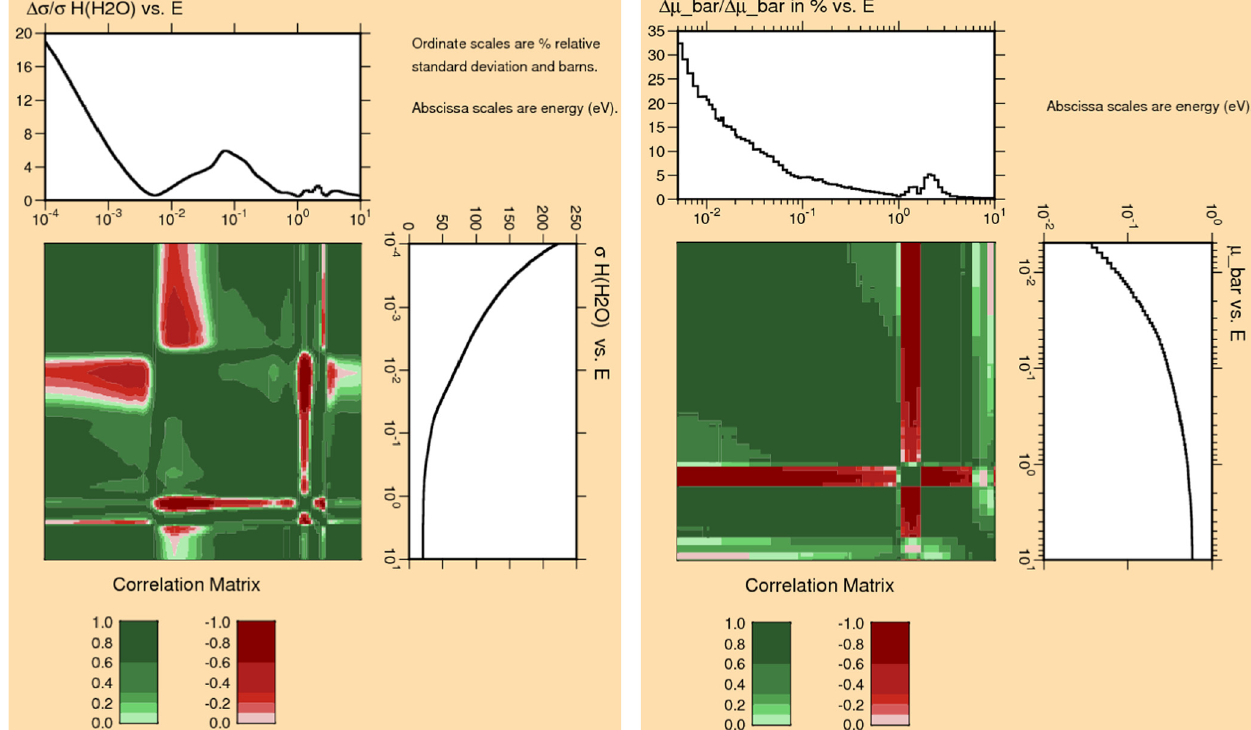
Fig. 7. Relative uncertainties and correlation matrix of the 1 H in H 2 O scattering cross section (left-hand plot) and of the average cosine m of the scattering angle (right-hand plot) calculated with the CAB model at 294 K with the uncertainties reported in Table 5.